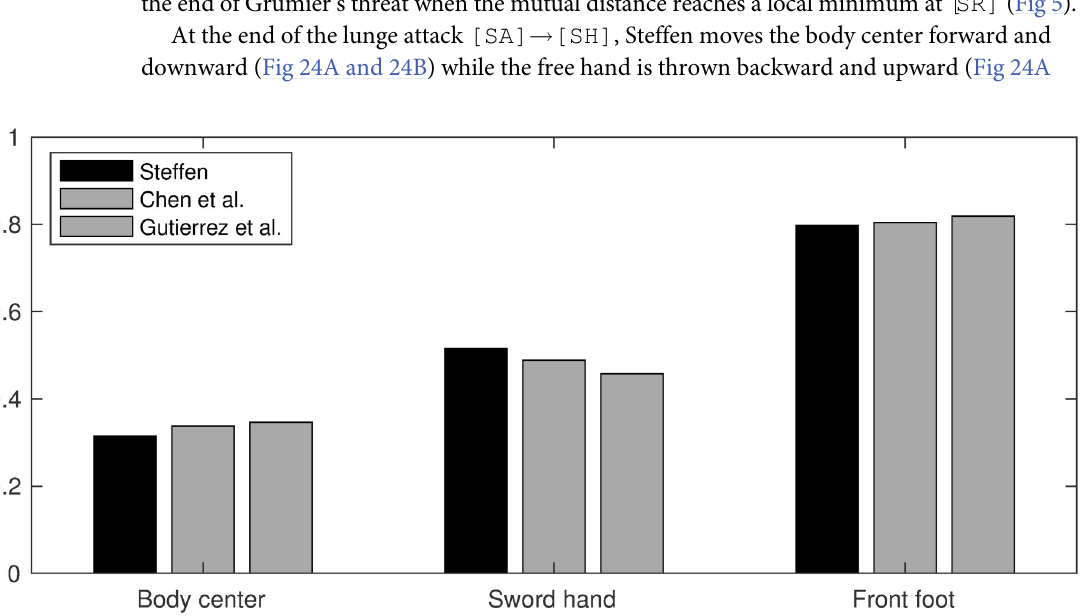
Fig 22. Normalized velocities. Steffen’s normalized velocities match those of Chen et al. [17] at 97% and Gutierrez-Davila et al. [18] at 94%, which is good accuracy.